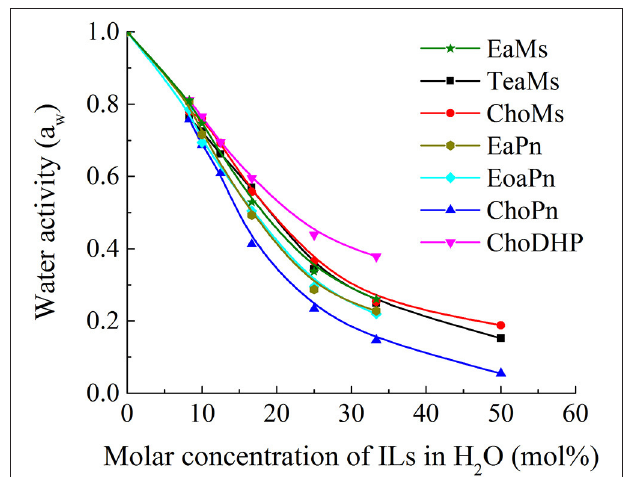
FIGURE 2 | Water activity of ILs as a function of molar